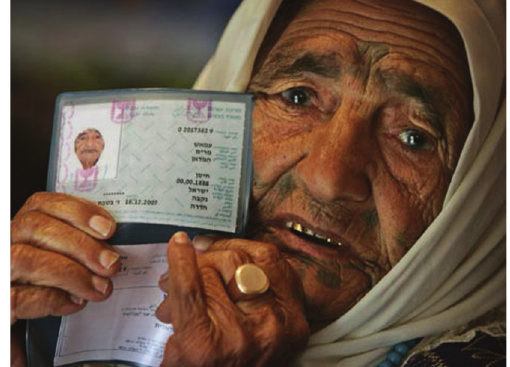
Figure 5: Mariam Amash’s family states that “She rises every morning around five for prayers ... . She then goes for a walk and then spends most of her day with the family. She recognizes all of us.” Such high function amongst people who validly claim ages even 10 years younger has never been observed by the New England Supercentenarian Study, which has enrolled 115 people aged 110 years or older as of December, 2010 (permission: The Daily